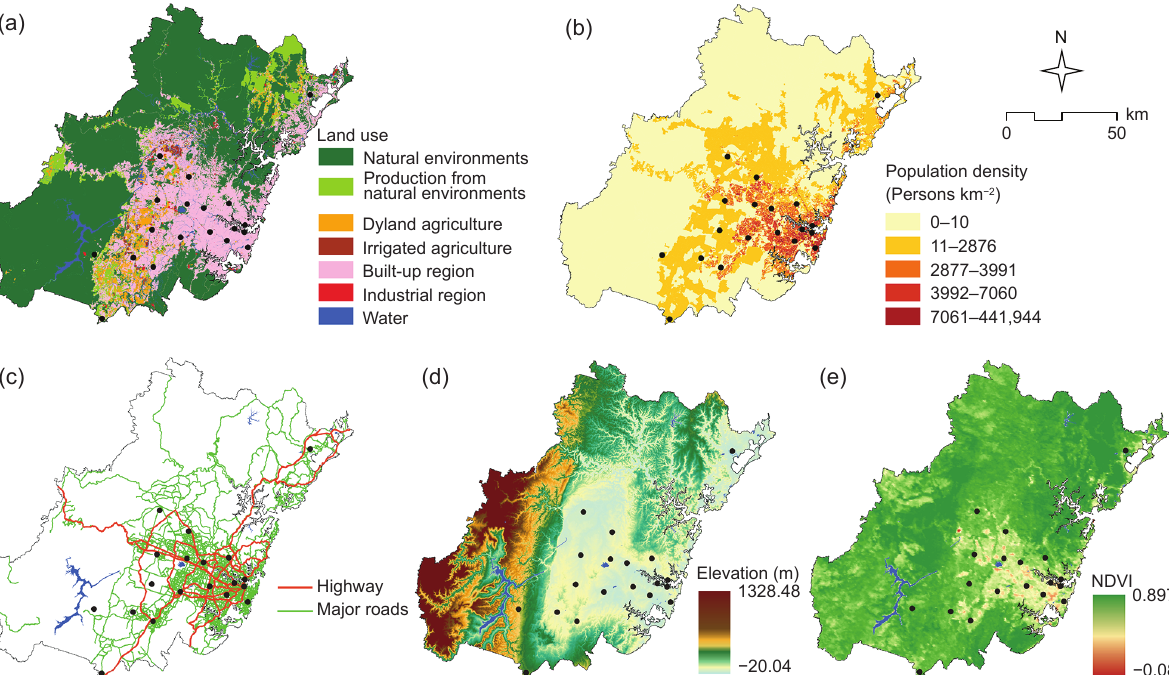
Figure 2. Spatial distributions of explanatory variables: land use ( a ), population density ( b ), road network ( c ), elevation ( d ), and vegetation (NDVI) ( e